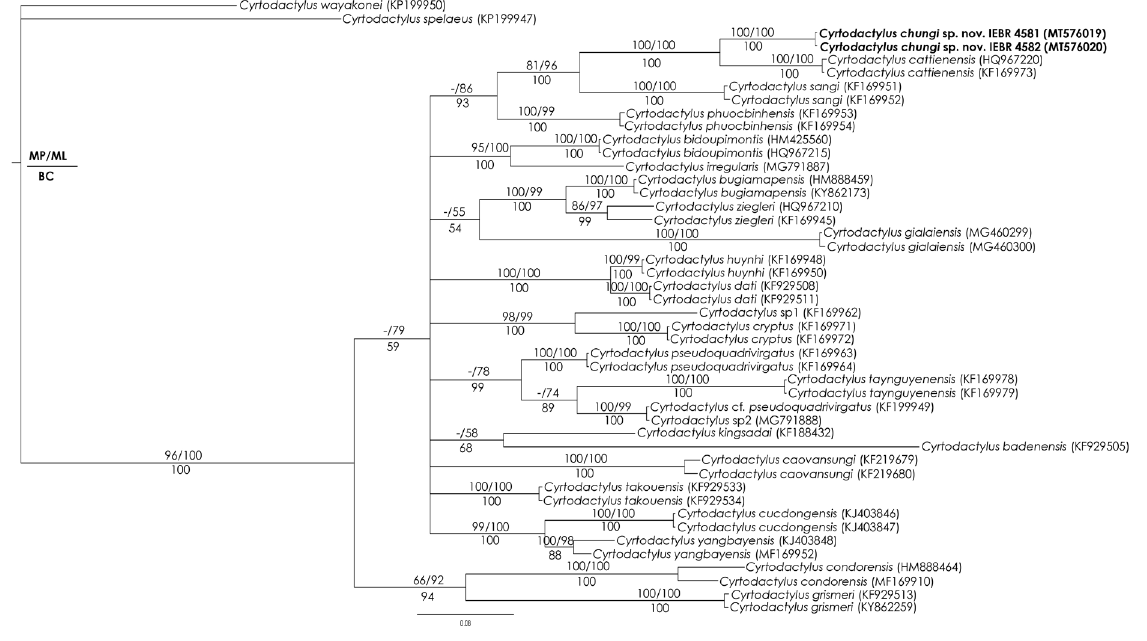
Fig. 2. Phylogram based on the Bayesian analysis. Number above and below branches are MP/ML bootstrap values and Bayesian posterior probabilities (> 50%),